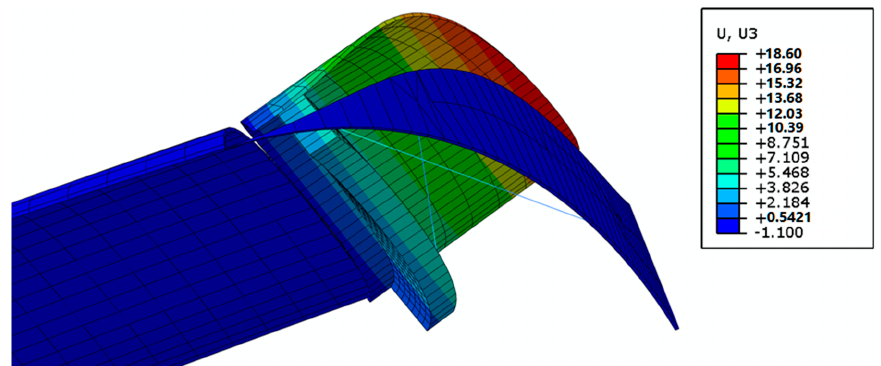
Figure 11. Case study #2: actuated structure. (unit: mm).